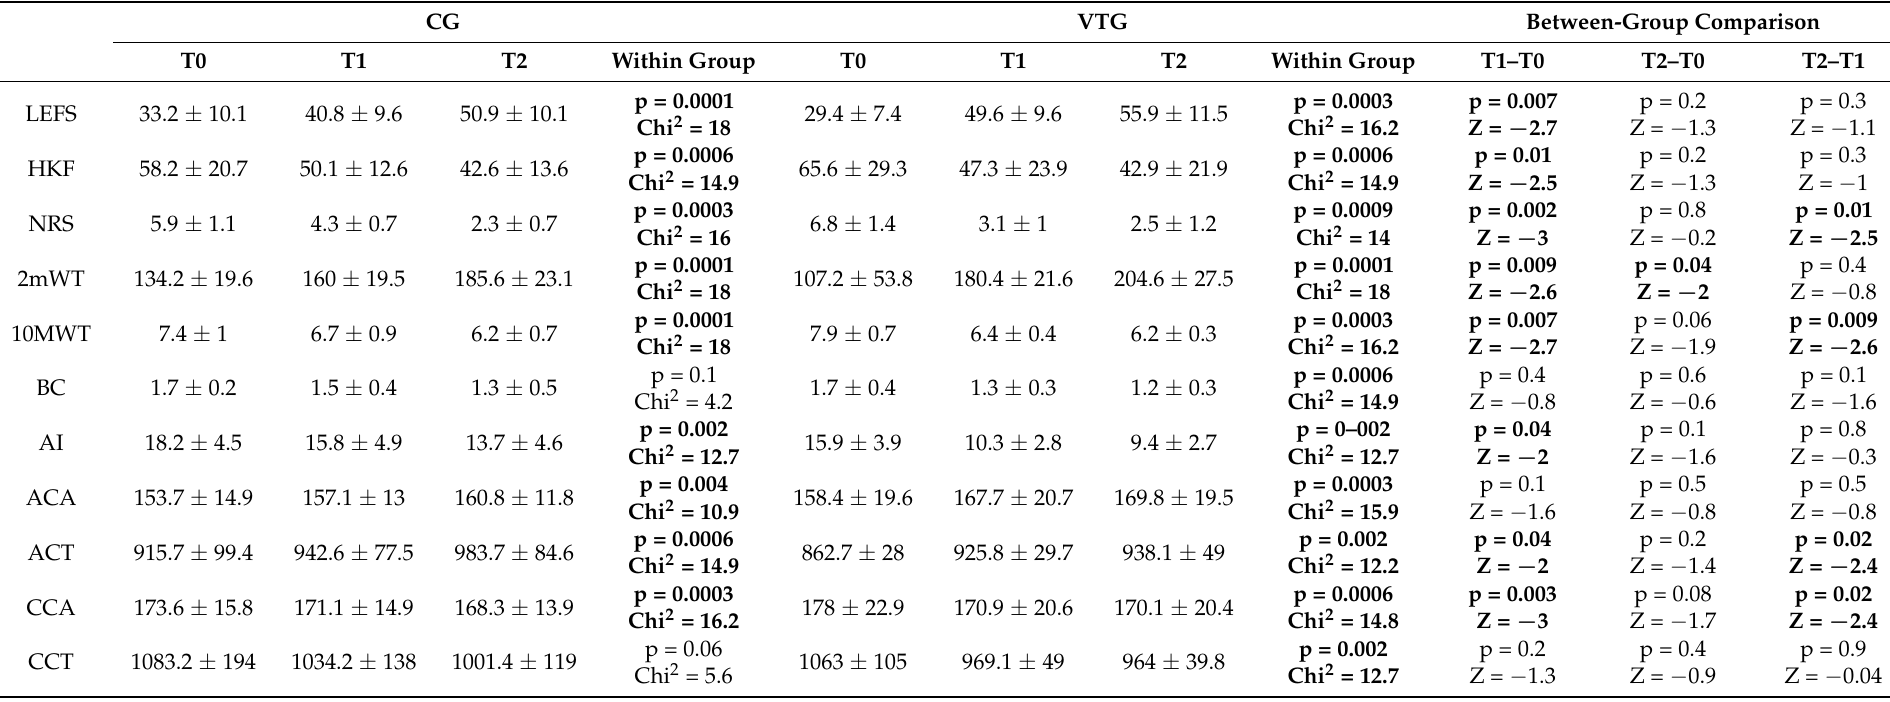
Table 2. Clinical variables at baseline (T0), after 4 weeks treatment (T1), and after rehabilitation